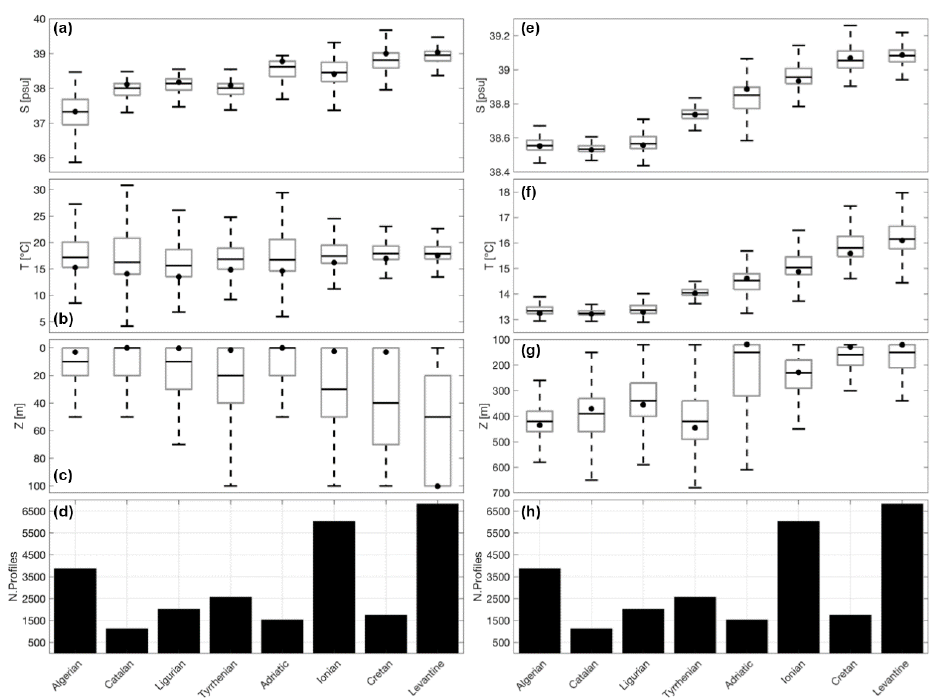
Figure 2. Boxplot diagrams for the AW salinity (a) , temperature (b) , and depth (c) in eight Mediterranean sub-basins. Inside each grey box, the bold black line indicates the median, while the bottom and top edges of the box indicate the 25th and 75th percentiles, respectively, and the black dots show the mode of each distribution, which corresponds to the maximum PDF. The number of profiles (black bars) for each sub-basin is shown in (d) . The corresponding diagrams for LIW are shown in (e) , (f) , (g) , and (h) .